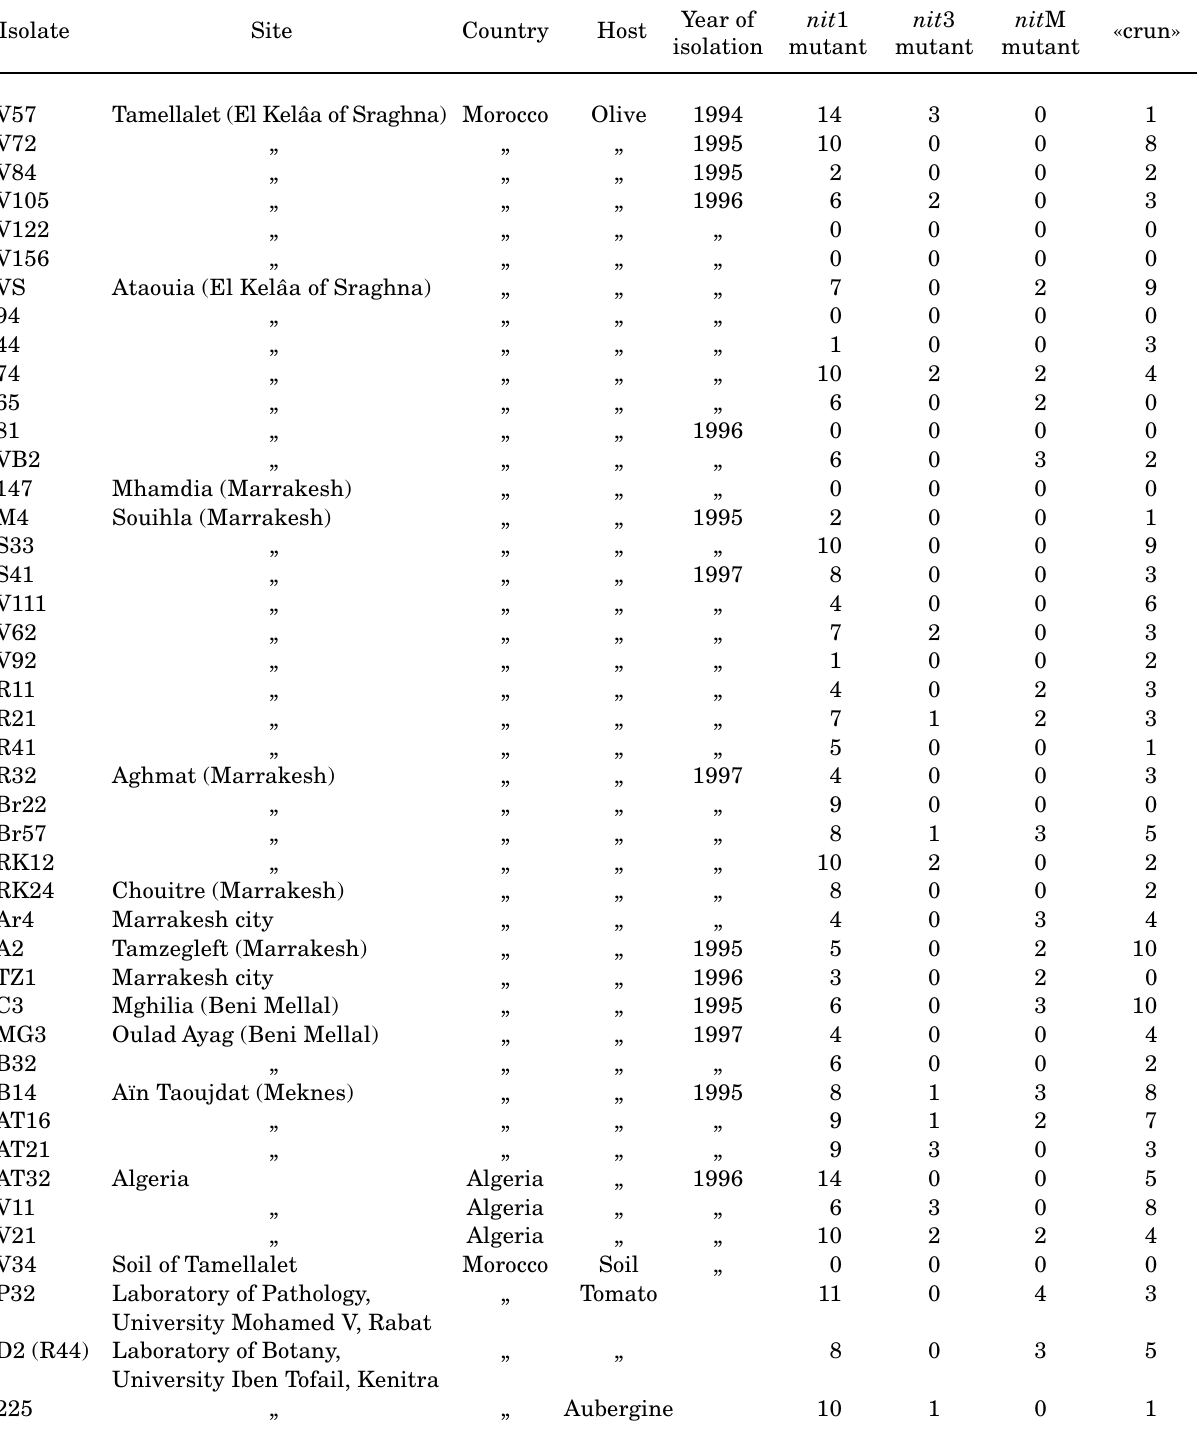
Table 1. Isolates of Verticillium dahliae used in this study, their host and geographic origin, year of isolation and number of different nitrate-nonutilizing ( nit ) mutants